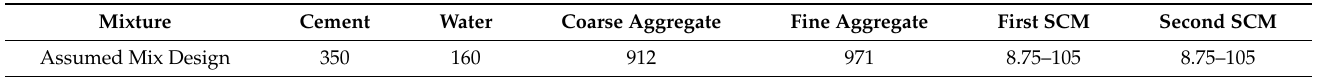
Table 9. The assumed mix design of concrete (All units in (kg/m 3